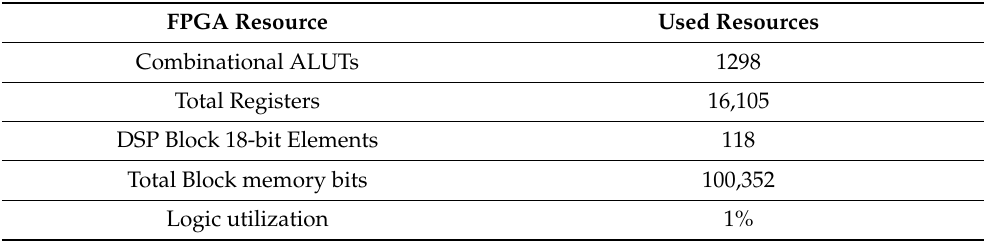
Table 4. FPGA chip statistics memristor solver only.